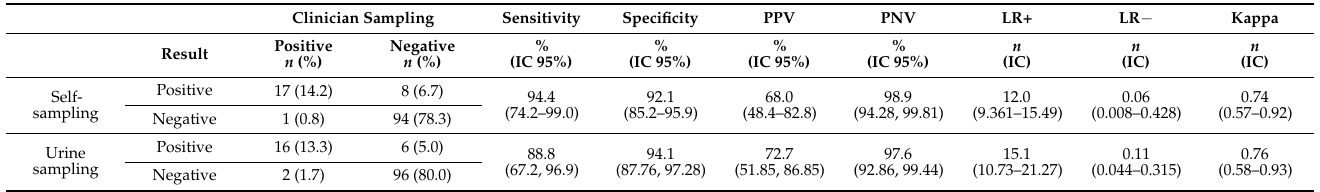
Table 3. Comparison of sensitivity, specificity, predictive values, likelihood ratio and correlation among three